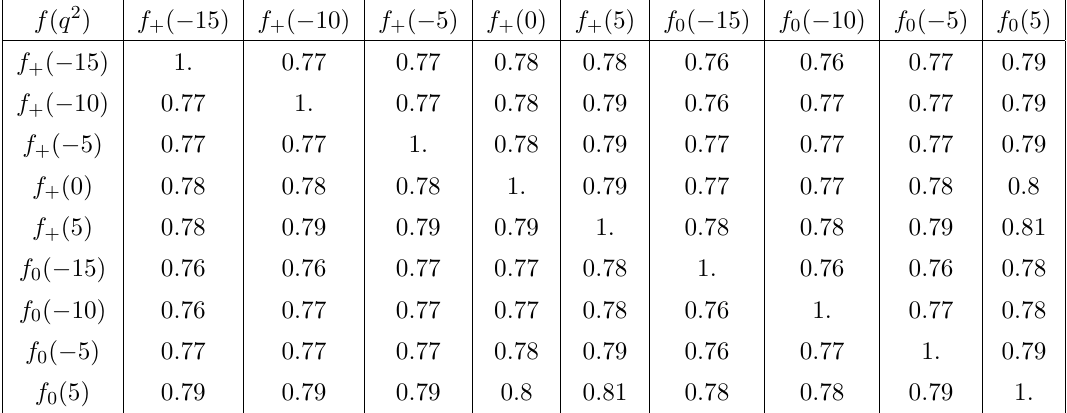
Table 14 . Correlation matrix of f + ( q 2 ) and f 0 ( q 2 ) at different values of q 2 from LCSR [14].